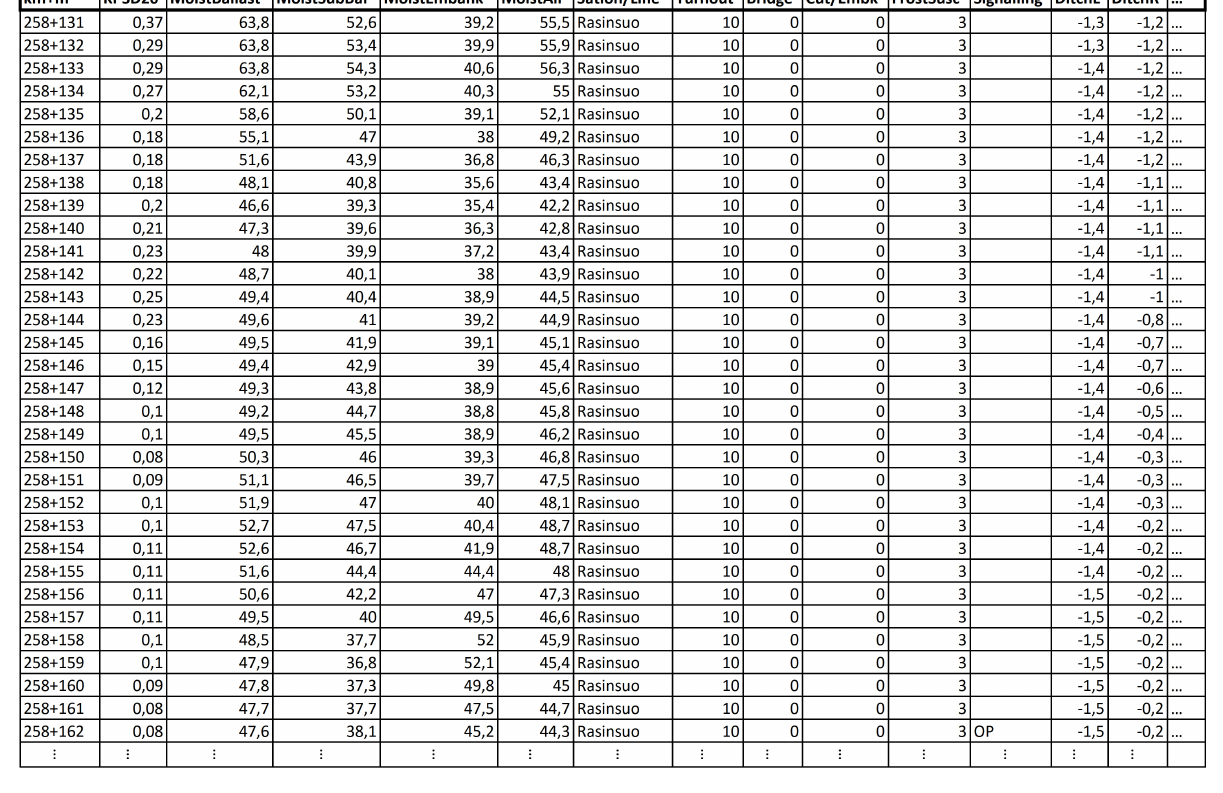
FIGURE 1 | Snapshot of the initial data.